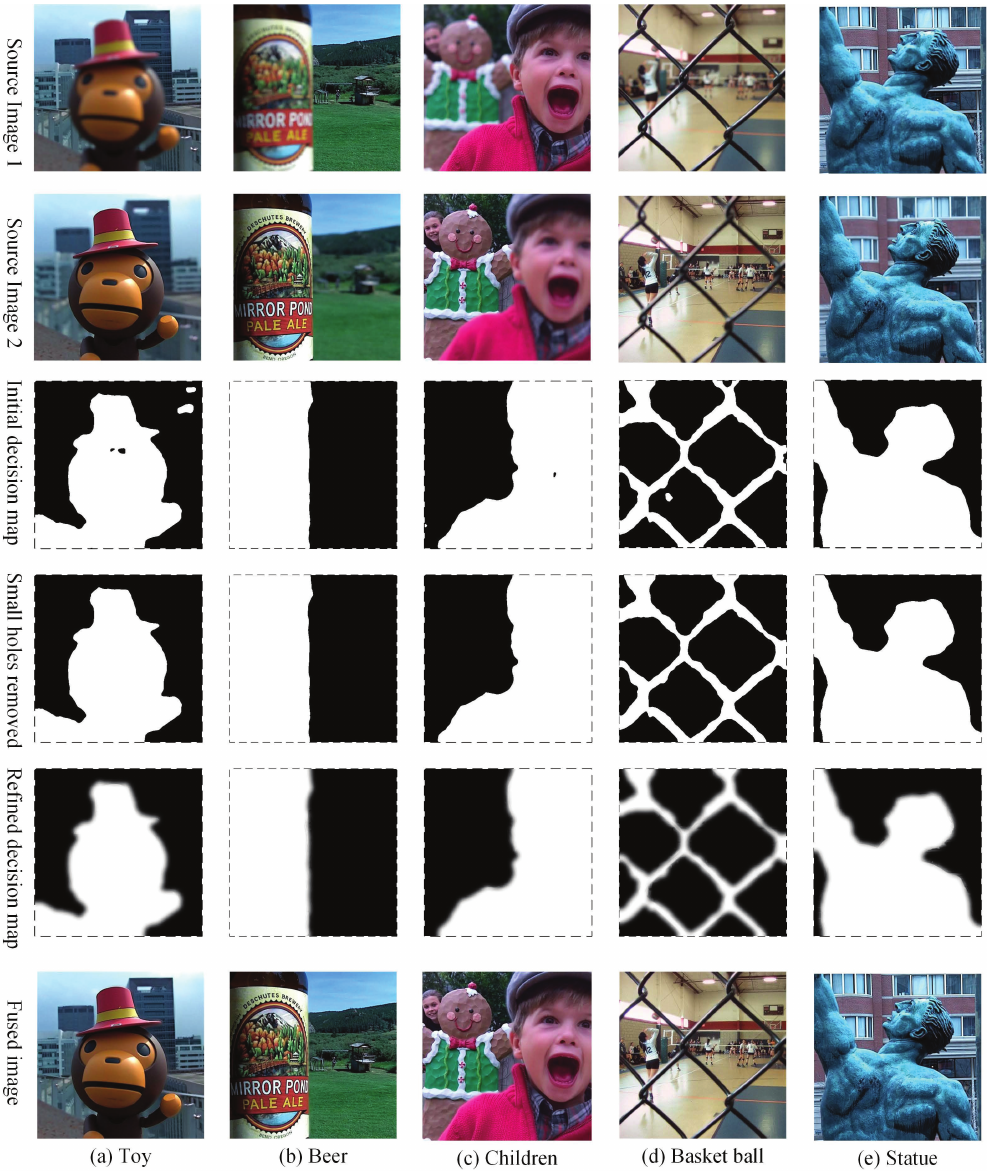
Figure 12. Fusion of a portion of the test images in the “Lytro” dataset.